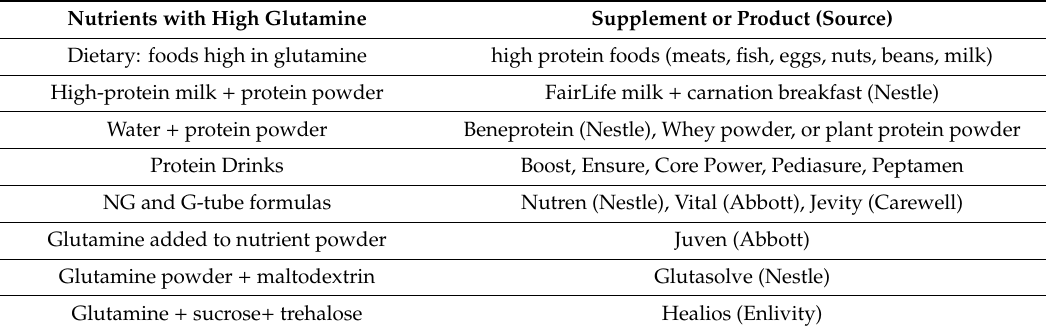
Table 3. Available supplements with glutamine in conjunction with cancer